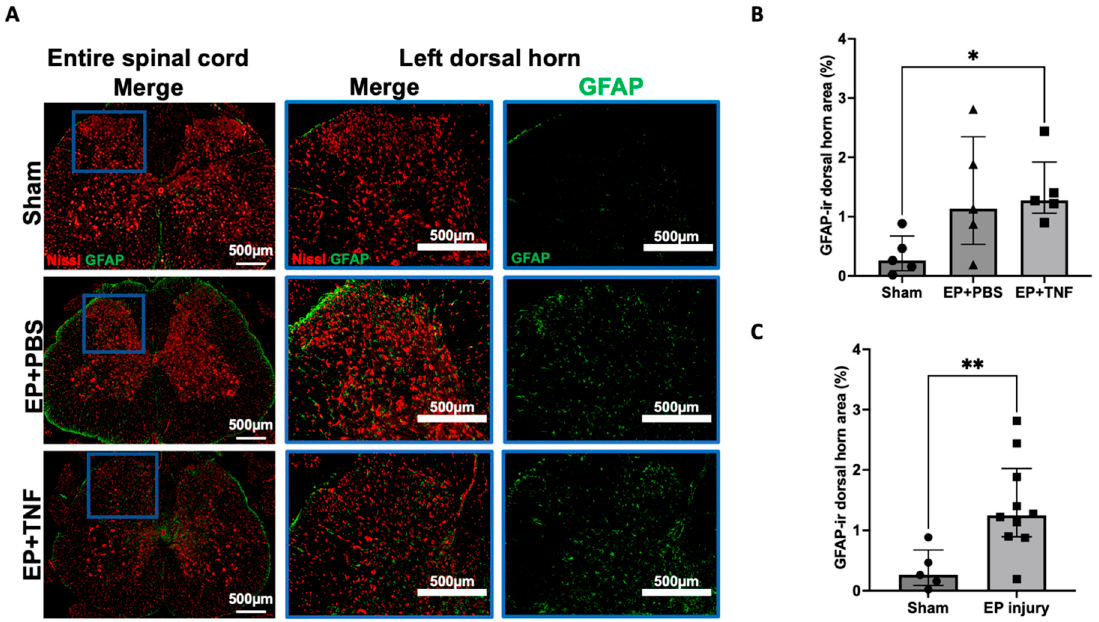
Figure 6. EP injury increased GFAP in the spinal dorsal horn with no effect of injectate. ( A ) Representative images of GFAP immunohistochemical staining with Nissl stain in the entire spinal cord and left dorsal horn. ( B ) EP injury with TNF α injection increased GFAP-ir in the spinal cord dorsal horn. ( C ) Combined EP injury increased GFAP-ir in the spinal cord dorsal horn. * p < 0.05. ** p < 0.01.